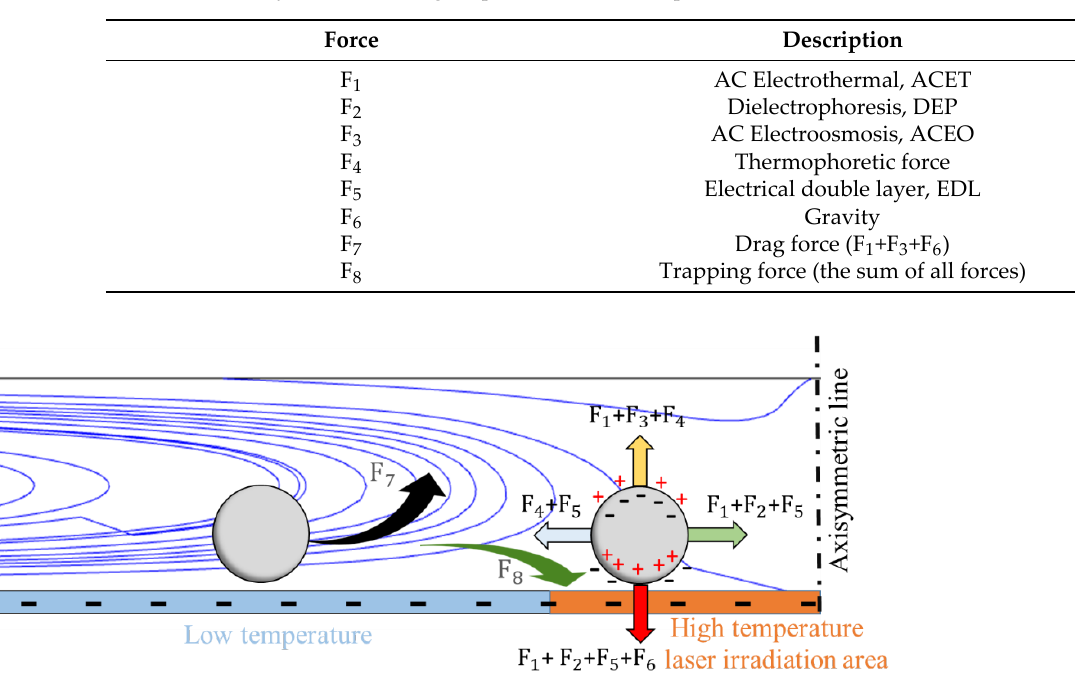
Table 2. Summary of forces acting on particles in REP chip.